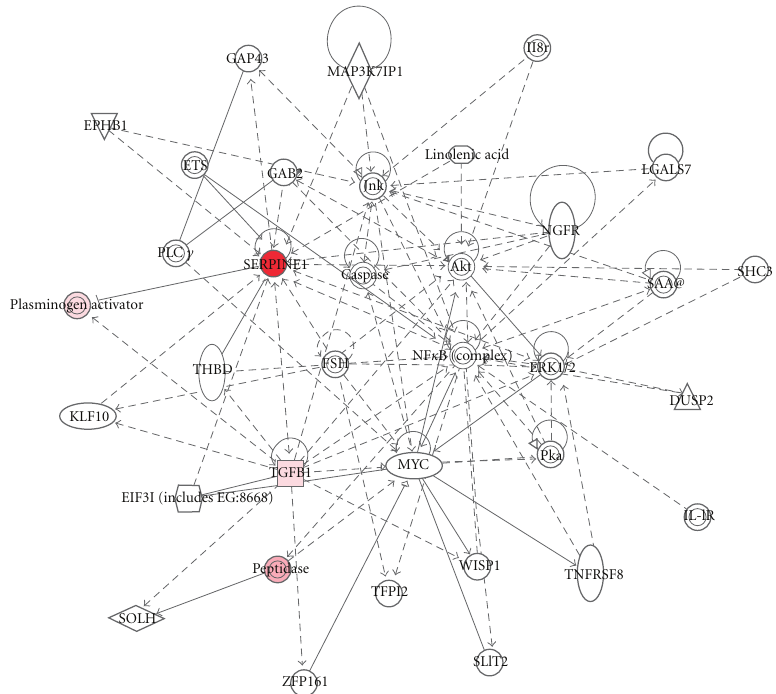
Figure 2: Integration of PAI-1 into cellular motile/proliferative pathways. Clustergram analysis of microarray data positions PAI-1 as a hub element both as a target and initiator (or inhibitor) of various pathways that regulate cellular motile (e.g., uPA, TGF- β 1), proliferative (e.g., ETS, MYC, AKT), and survival/stress (e.g., JNK, caspase, NF κ B, TNFR)